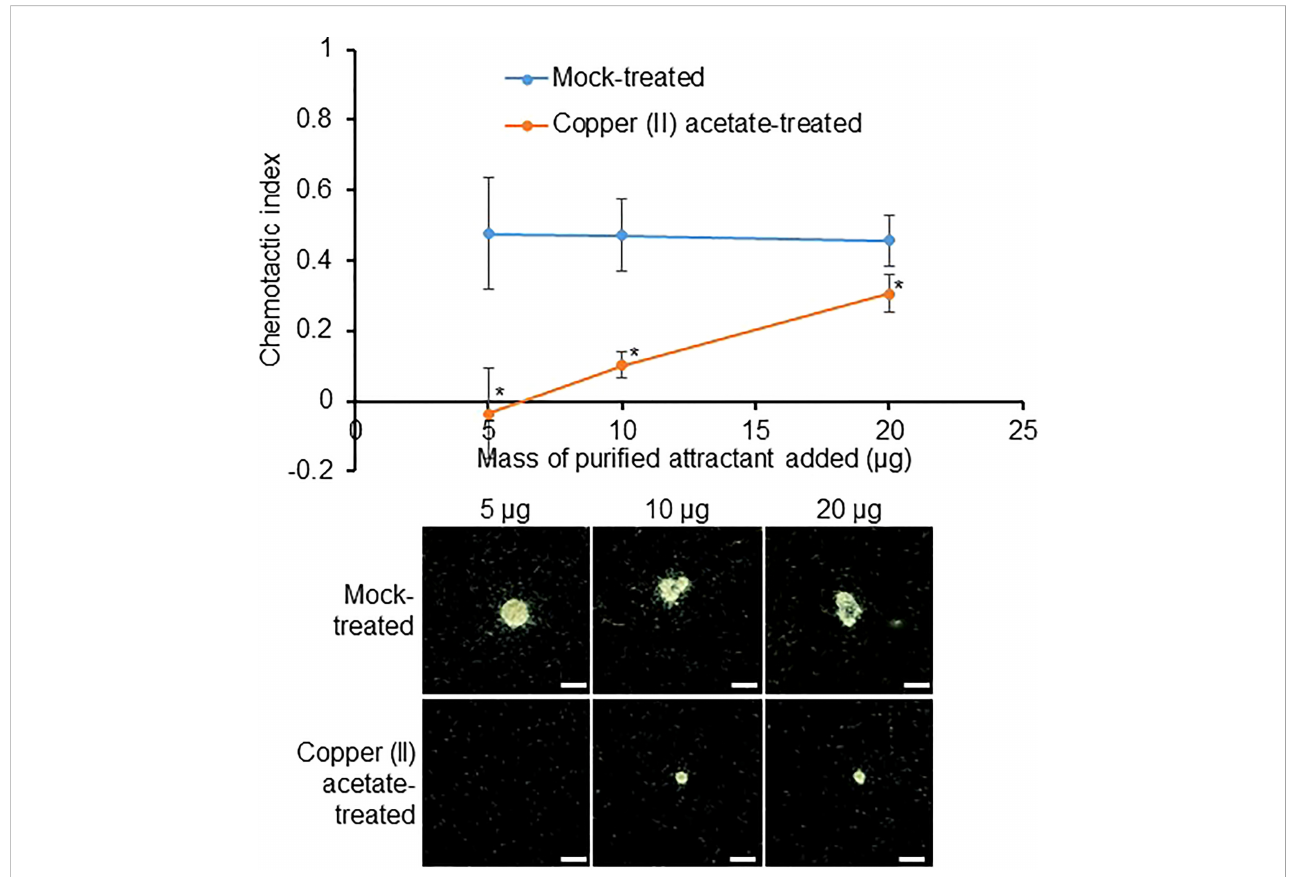
FIGURE 5 The active compound in the RKN attractant puri fi ed from SR culture media may be pectin. RKN chemotactic indexes of attractant puri fi ed from SR culture media treated with copper(II) acetate to precipitate pectin. Averages from n = 3 ± SD are shown. *denotes signi fi cant differences from mock- treated samples, P<0.05, student ’ s T-test. Bottom panels show representative RKN behavior in vitro in the presence of the attractant, scale bars = 2